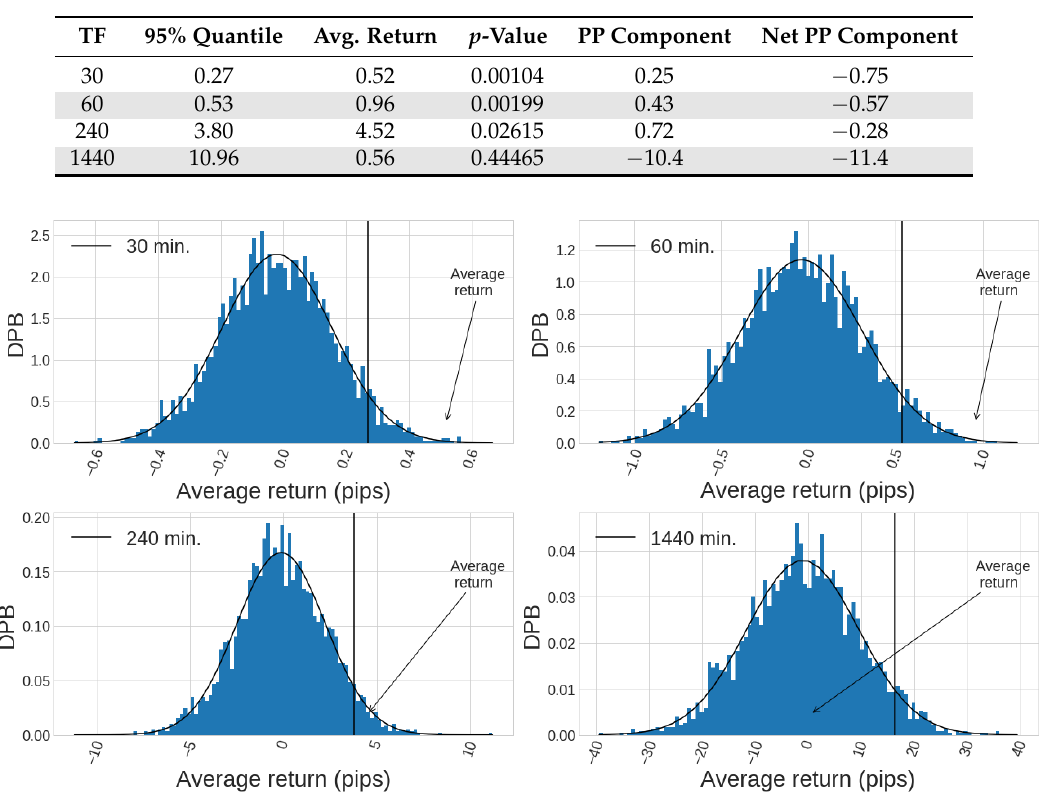
Figure 12. Normalised histograms are shown for 3000 Monte Carlo distributions of average returns for each timeframe for the period considered (second half of the whole historical data, which is the total out of sample period). The y-axis represents the probability density function. A vertical line has been drawn for the 95% quantile, to show which is the threshold above which a mean return is a reflection of predictive power. The mean return of each out-of-sample equity curves are marked in the figure with an arrow (¯ r 30 = 0.52 pips, ¯ r 60 = 0.96 pips, ¯ r 240 = 4.52 pips, ¯ r 1440 = 0.56